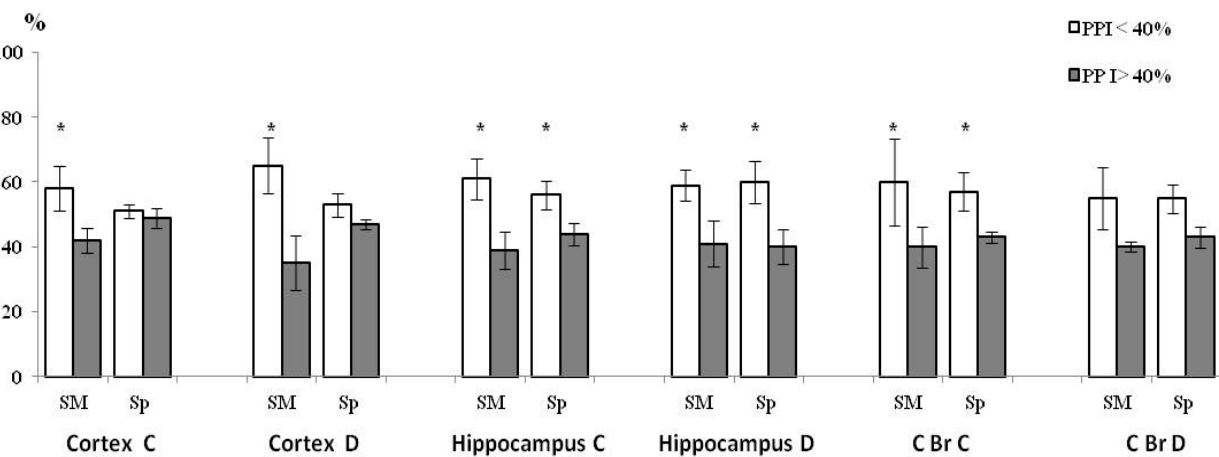
Figure 2. ChAT activity distribution (means ± SEM%) in the control sub-groups of rats with PPI< and >40% ( n = 3 for each